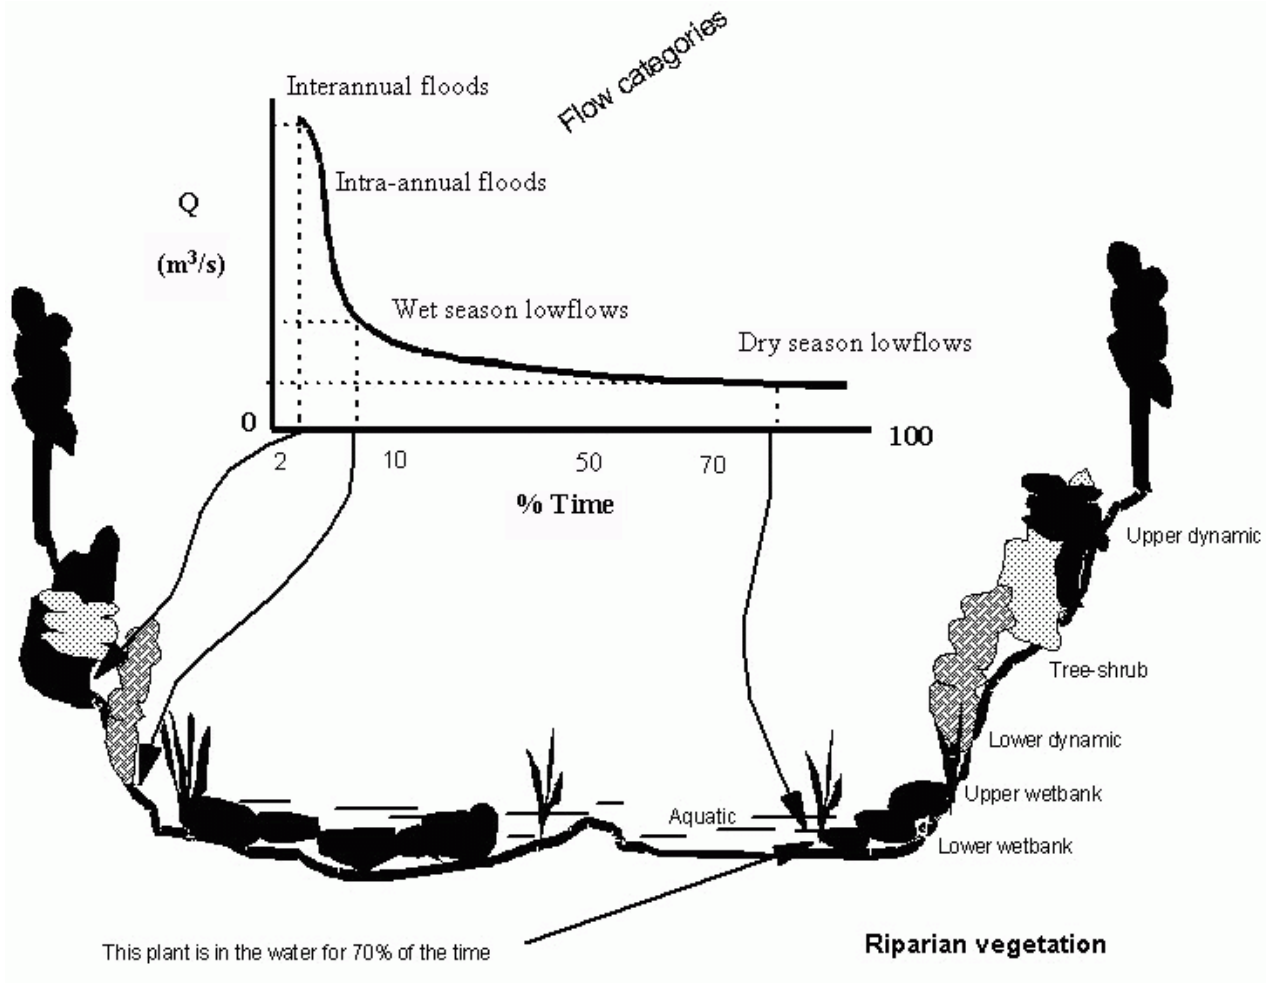
Fig. 2 . Use of a flow duration curve to estimate the inundation exposure regime of riparian vegetation zones. Q stands for